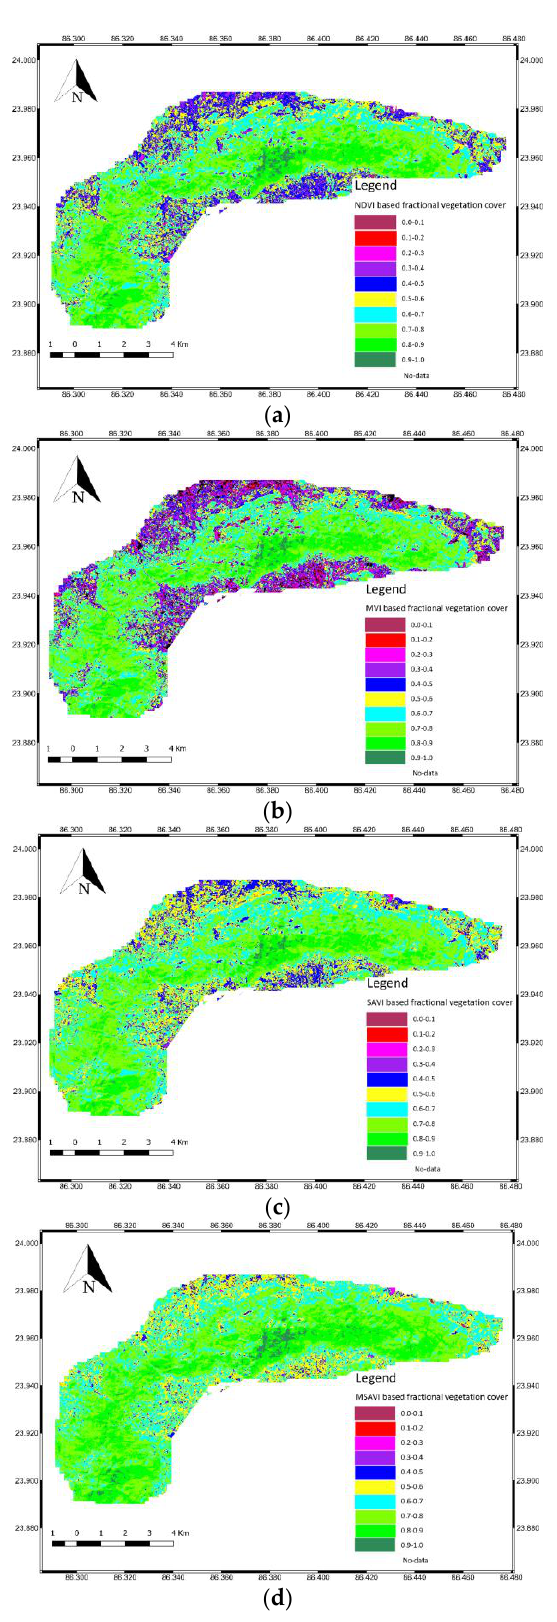
Figure 3. Calculated forest fraction of vegetation cover ( FVC ) images based on ( a ) normalized difference vegetation index ( NDVI ), ( b ) modified vegetation index ( MVI ), ( c ) soil-adjusted vegetation index ( SAVI ), and ( d ) modified soil-adjusted vegetation index ( MSAVI ), from the study